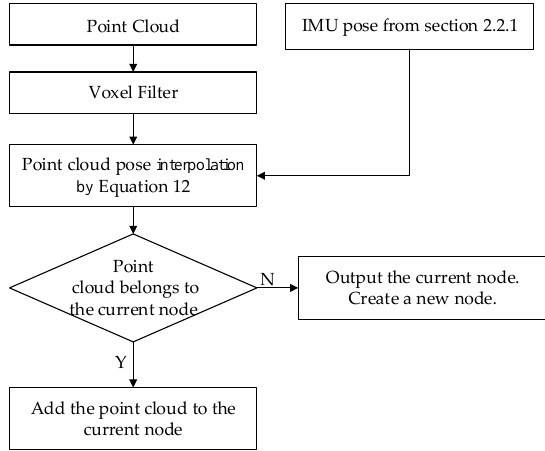
Figure 2. Flow chart of local registration.